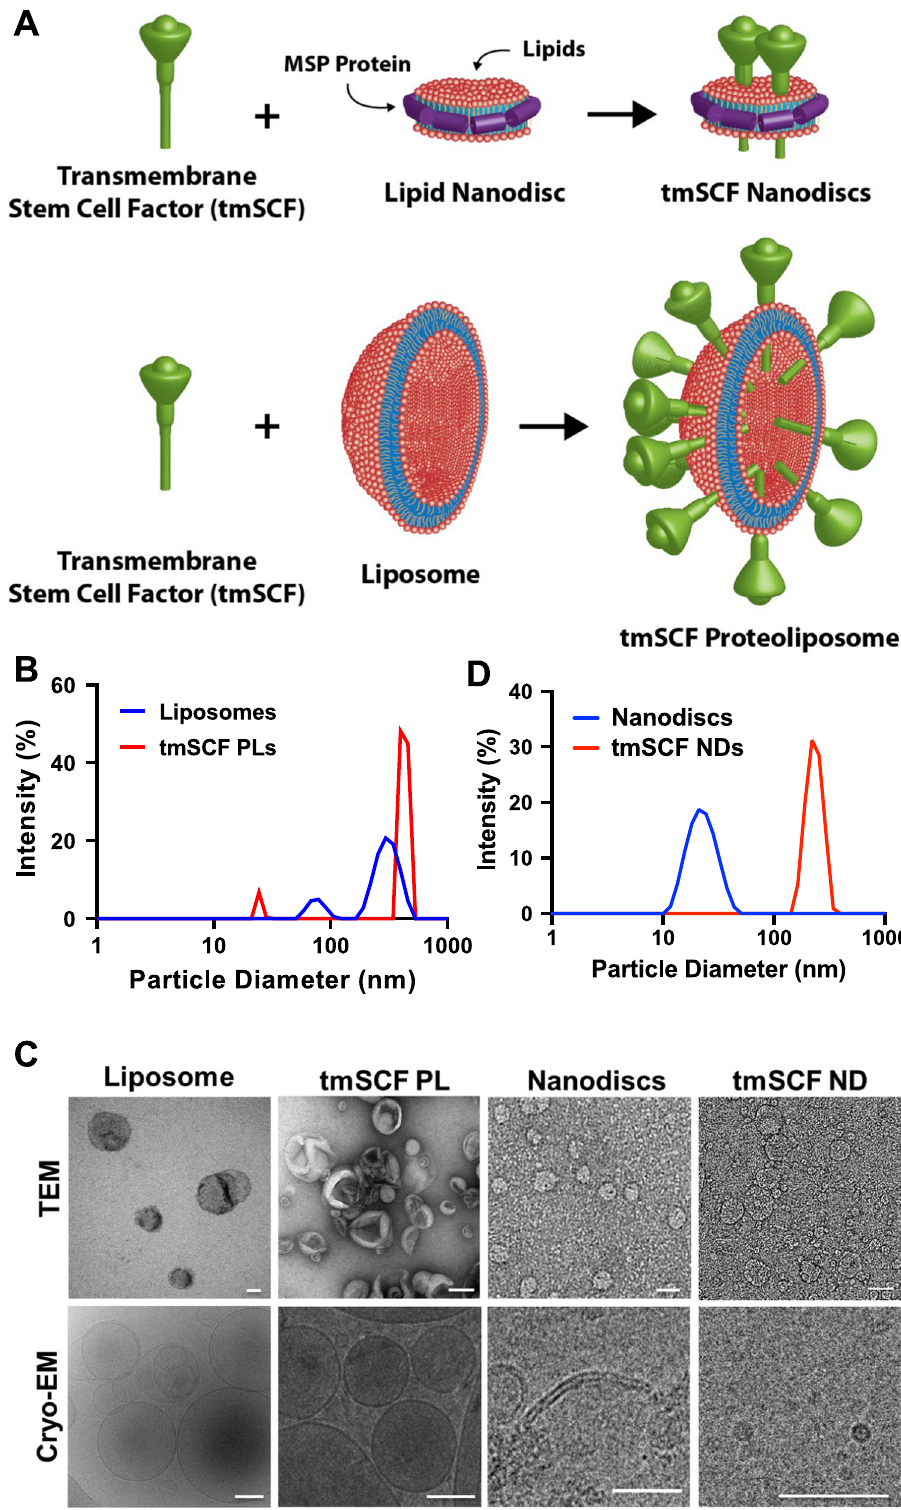
Fig. 1 Characterization of tmSCFPLs and tmSCFNDs by DLS and electron microscopy. A Schematic illustration of tmSCF proteoliposomes (tmSCFPLs) and tmSCF nanodiscs (tmSCFNDs). B Size distribution for liposomes and proteoliposome with tmSCF measured by dynamic light scattering. C Size distribution for nanodiscs and tmSCF nanodiscs. D Representative TEM and cryo-EM images of liposomes, tmSCFPLs, nanodiscs, and tmSCFNDs. Scale bar = 100